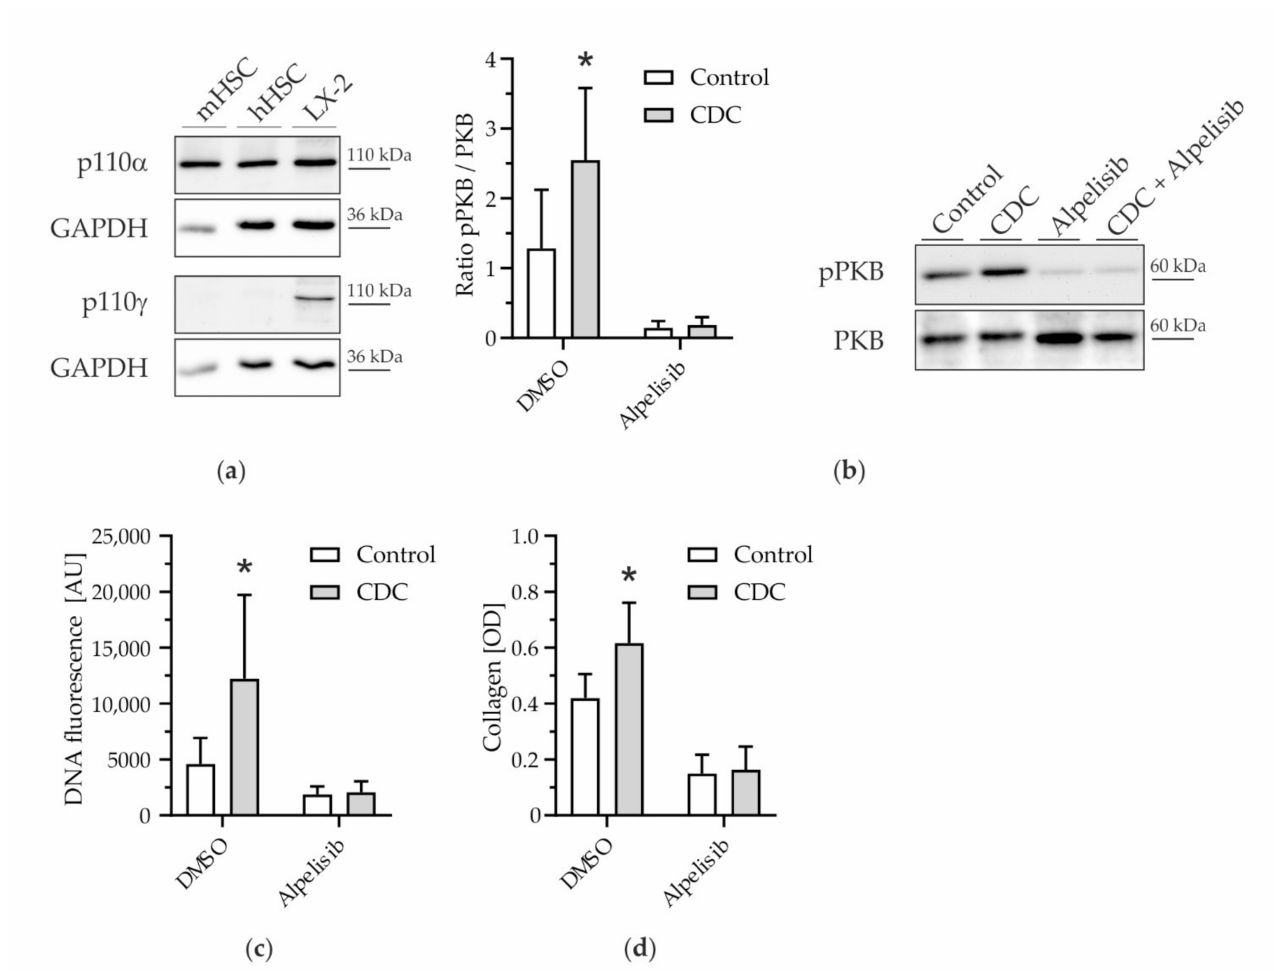
Figure 3. Pro-fibrogenic effects of CDC in HSCs are mediated by PI3K p110 α . ( a ) Protein expression of catalytic PI3K isoforms p110 α and p110 γ in hepatic stellate cells (mHSCs: murine hepatic stellate cells; hHSCs: human hepatic stellate cells; LX 2: HSC cell line LX 2). GAPDH was used as a